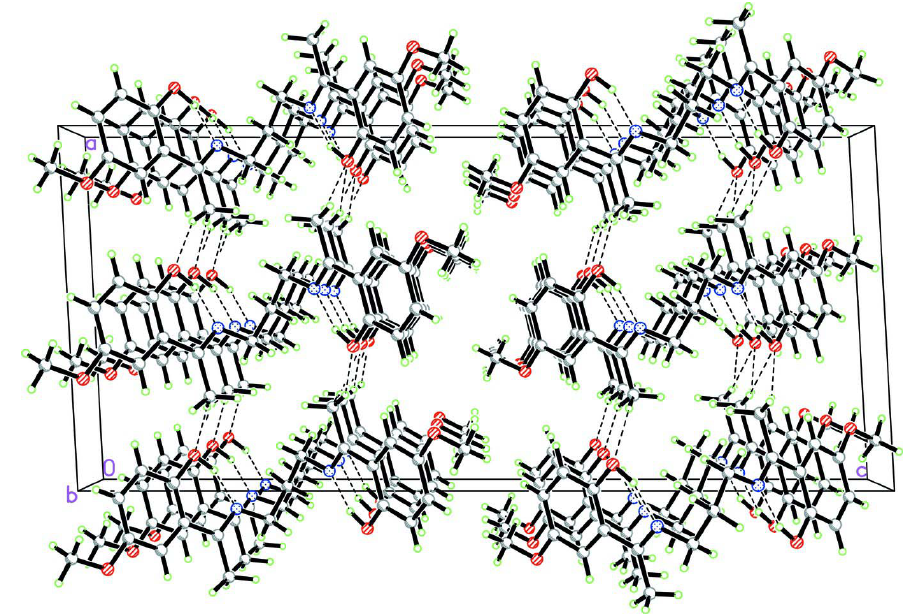
Figure 2 The crystal packing, showing stacking of molecules down the b axis. Intramolecular and intermolecular interactions are shown as dashed